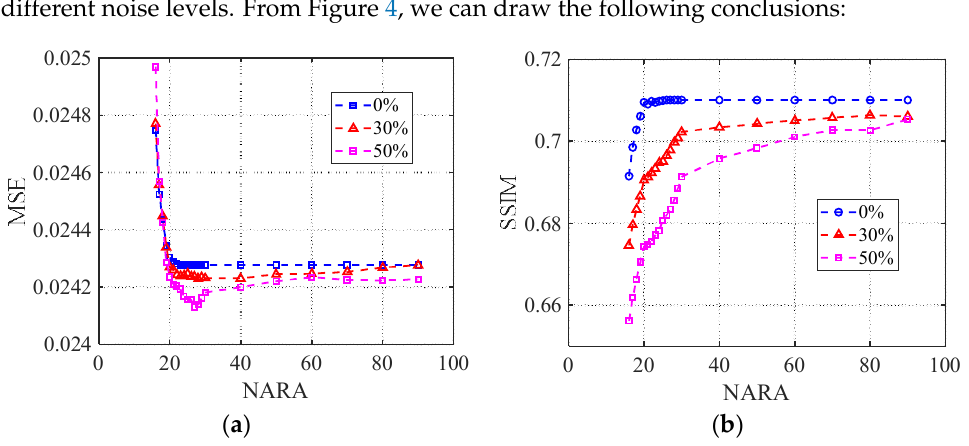
Figure 3. Interpolation error using FDZP and skeletonization-based method varying with the NARA for circular and elliptical antenna distribution shapes.